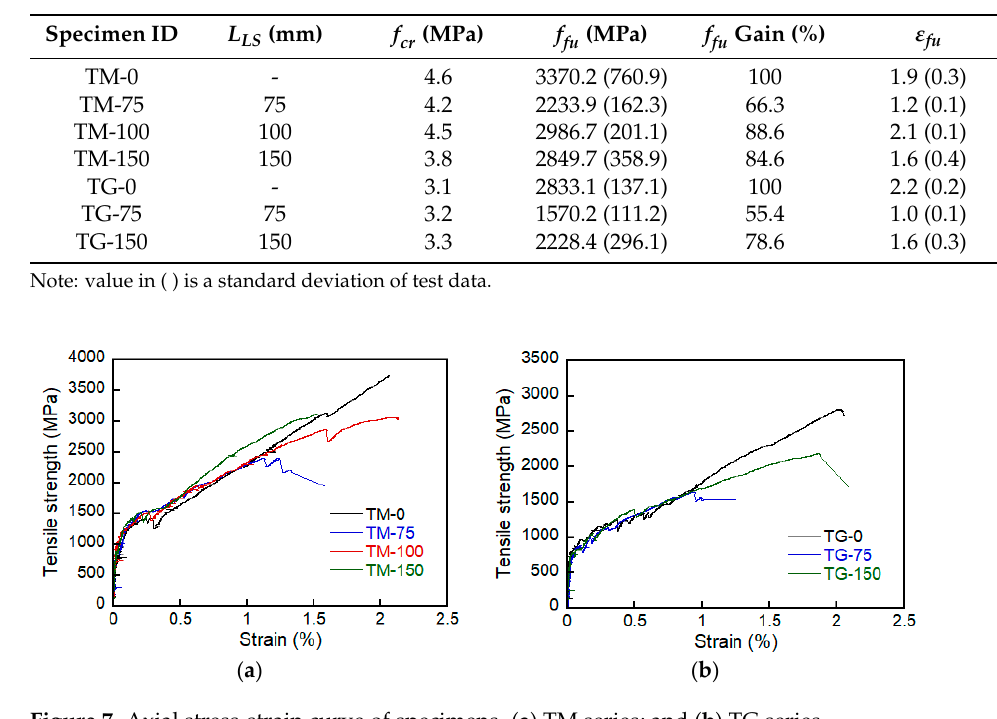
Table 5. The results for direct tension tests (average values of three tests).